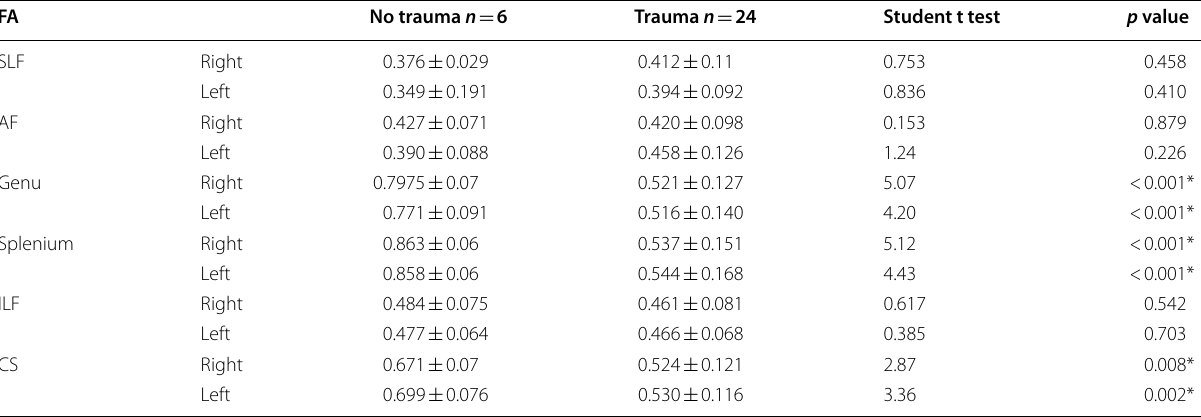
Parameters described as mean